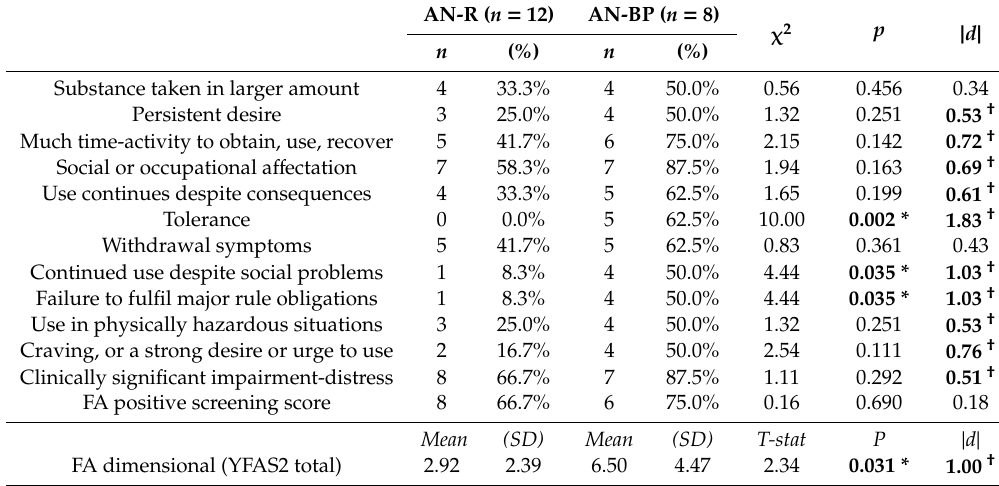
Table 2. Comparison of the FA measures between AN